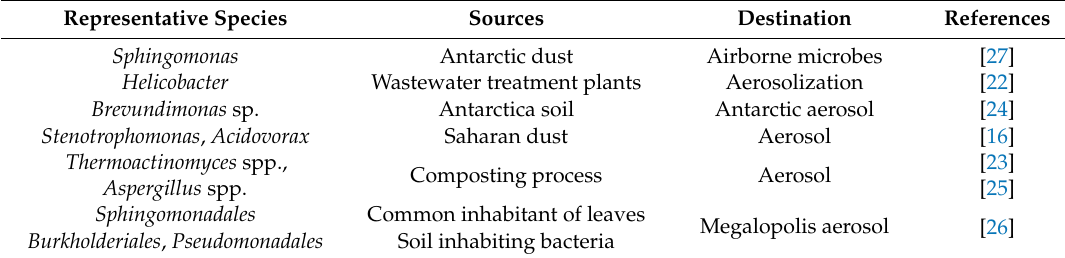
Table 1. Source of representative species in